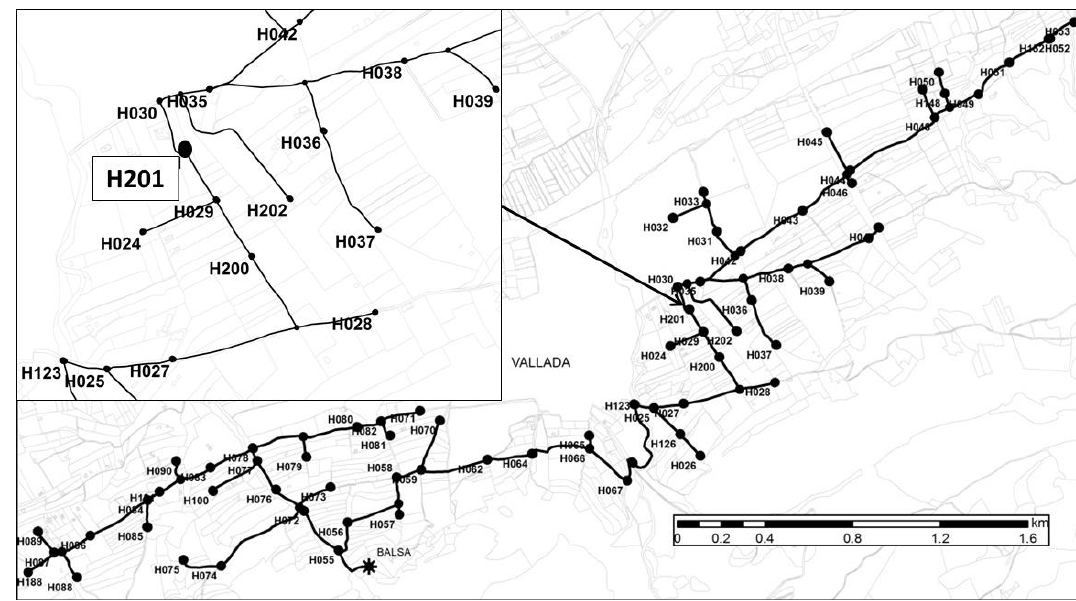
Figure 13. Identification of hydrants in the irrigation network.